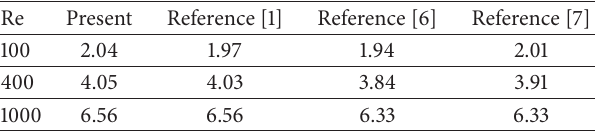
Table 1: Comparison of the average Nusselt number at the hot wall in this work and that reported in previous studies for Da = 10 6 , Ri = 10 − 2 , 𝜀 = 0.999, and 𝜏 =